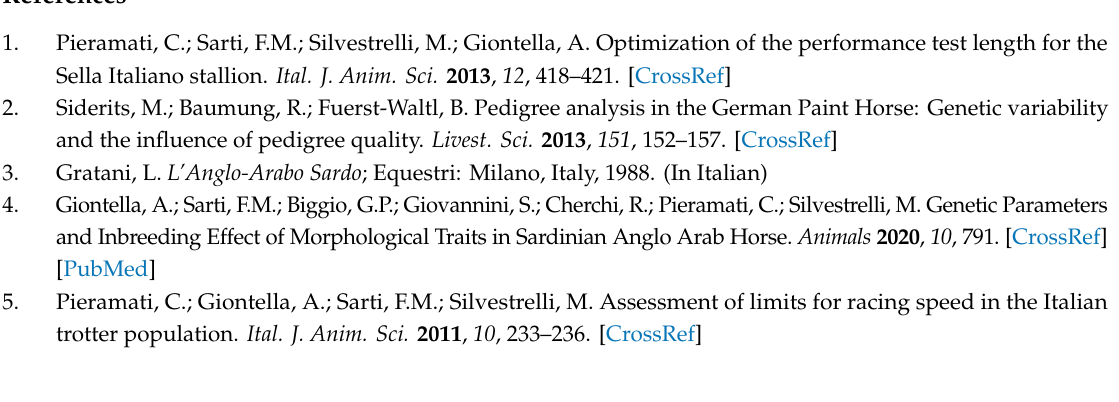
Table S1: List of 56 Sardinian Anglo-Arab horse samples herein analyzed. Table S2: List of 170 mtDNA control regions from Cardinali et al. 2016 included in the